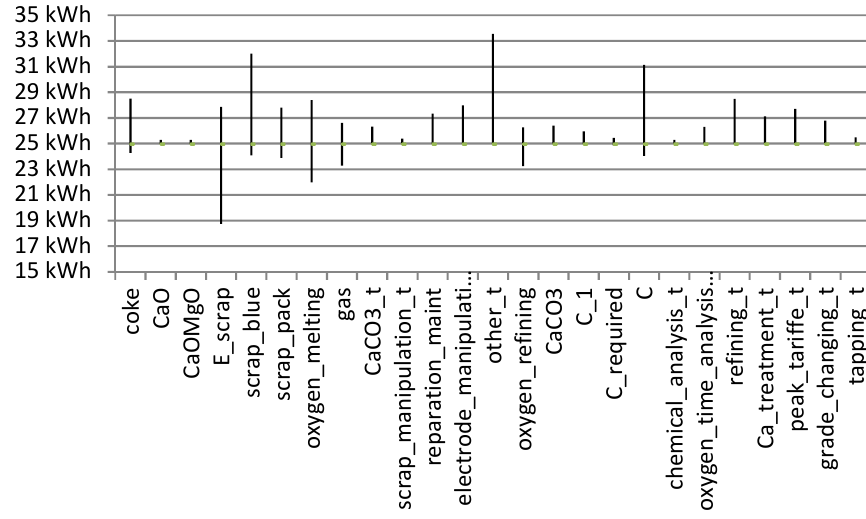
Figure 2. The calculated influences of the individual parameters on the electric energy consumption using the linear regression model.